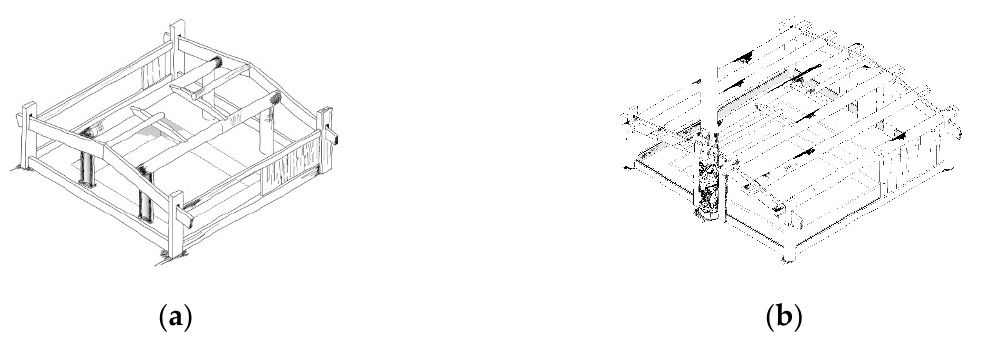
Figure 1. ( a ) Four beams model based on [1] (p. 270); ( b ) Six beams model based on [1] (p. 270).